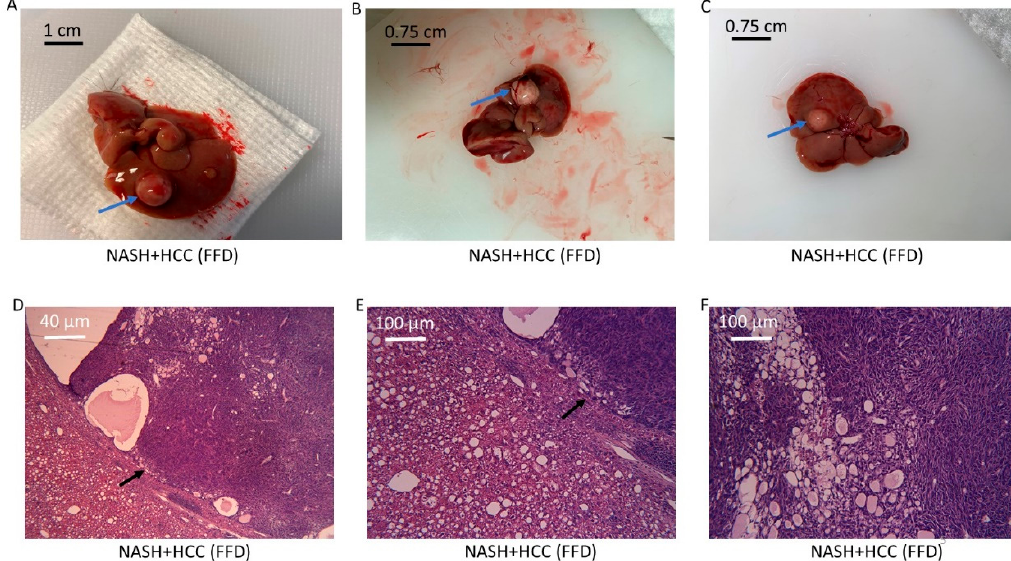
Figure 4. NASH with hepatocellular carcinoma (HCC). ( A – C ) Several animals within the FFD (17 mo) cohort exhibited liver tumors, which manifested as one or more polyp-like (blue arrows) growths on the liver. ( D – F ) Representative H&E-stained section from an FFD (17 mo) liver showing a trabecular growth pattern of atypical hepatocytes and clusters of nuclei (F, 25 × ) with a distinct margin between the noncancerous and cancerous parenchyma (black arrows, (D) (4 × ) and (E) (10 × )). This liver bore a large tumor at sacrifice. Steatosis is also evident ( E ).